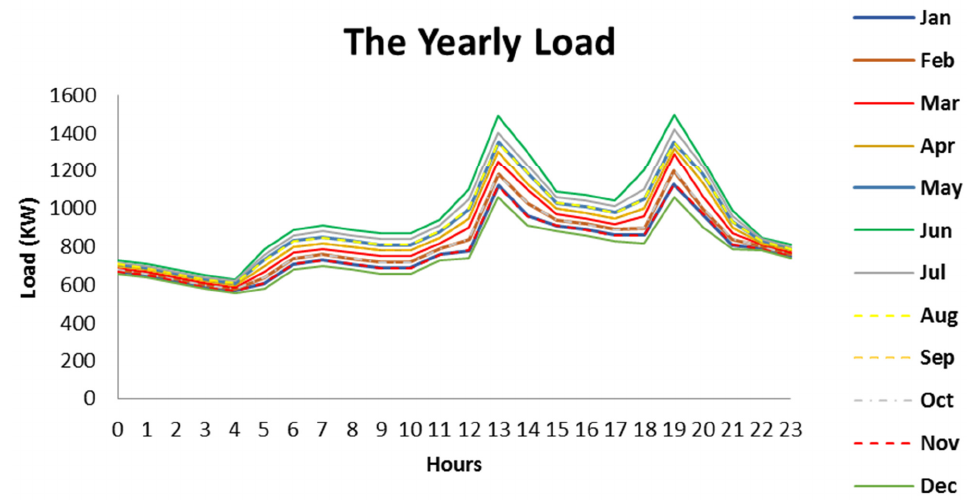
Figure 4. Variation of hourly average load for every month during the year.